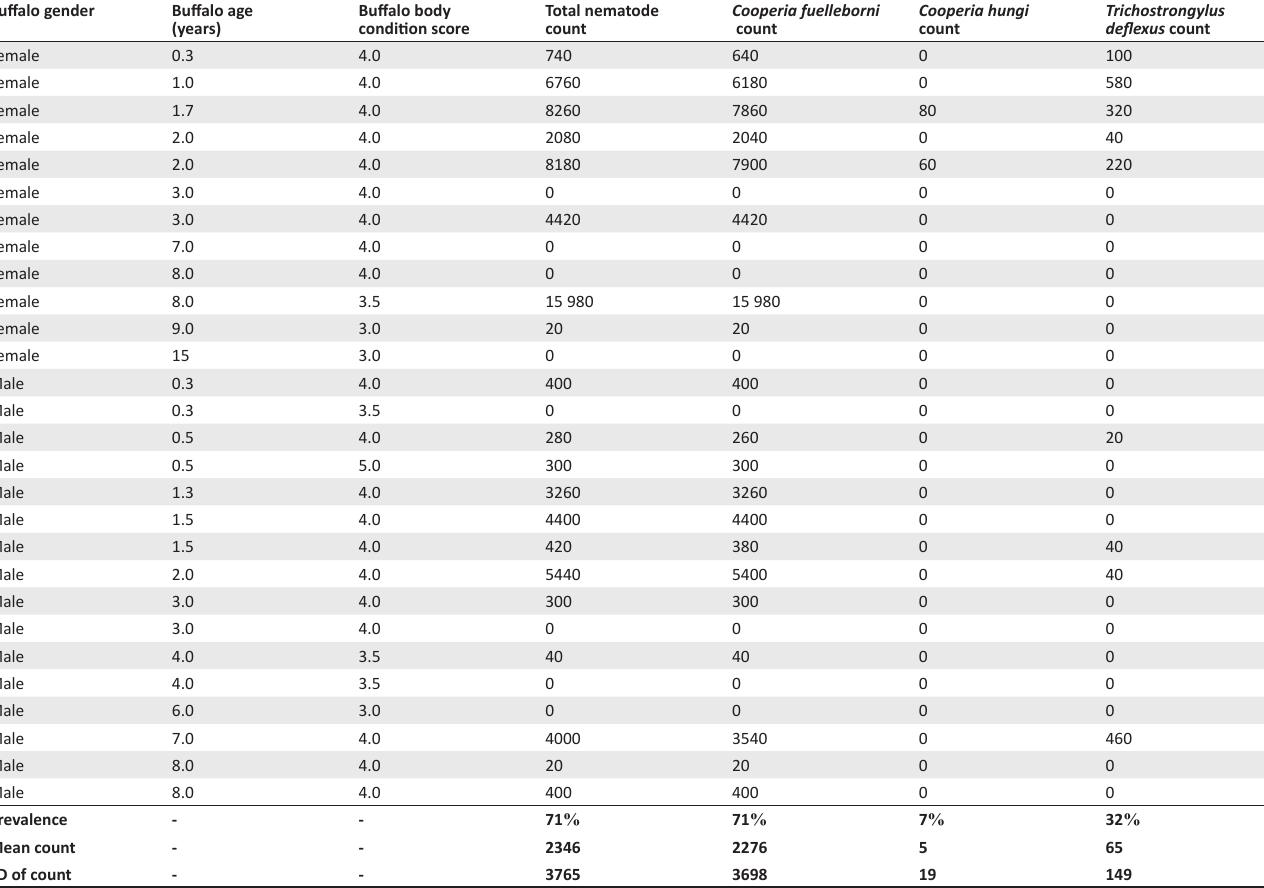
TABLE 1: Individual buffalo statistics and nematode infection results for 28 African buffaloes culled in the Kruger National Park, July 2005. Buffalo gender Buffalo age Buffalo body (years) condition